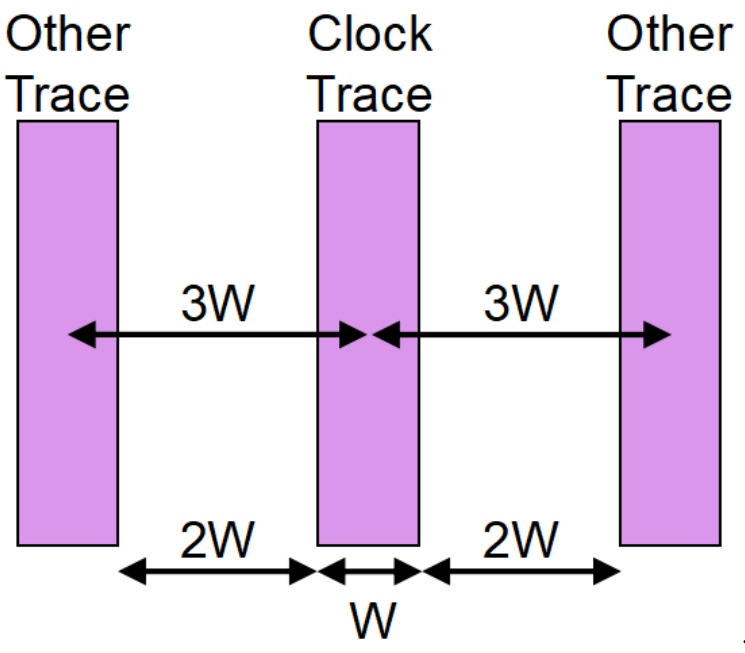
Figure 7. Principle of 3 times line width.